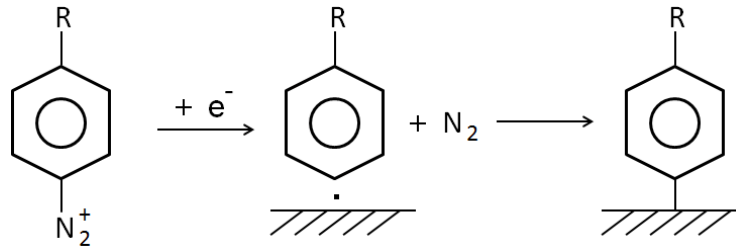
Figure 10. The reaction mechanism for aryl diazonium reaction based SAM (adapted from